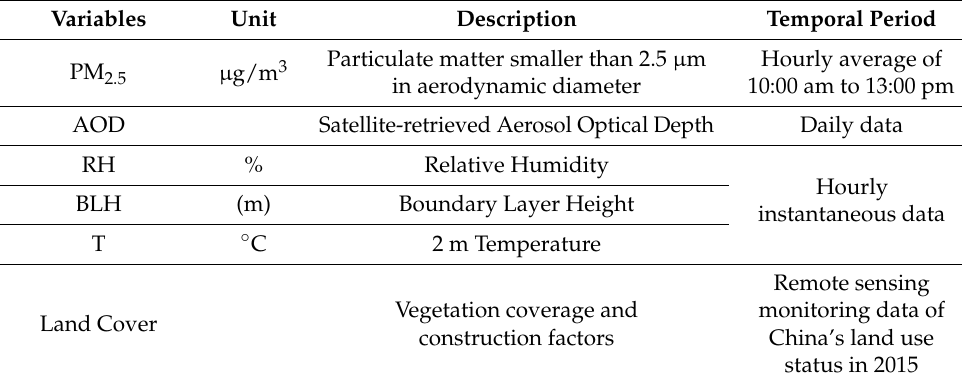
Hourly instantaneous Remote sensing monitoring data of China’s land